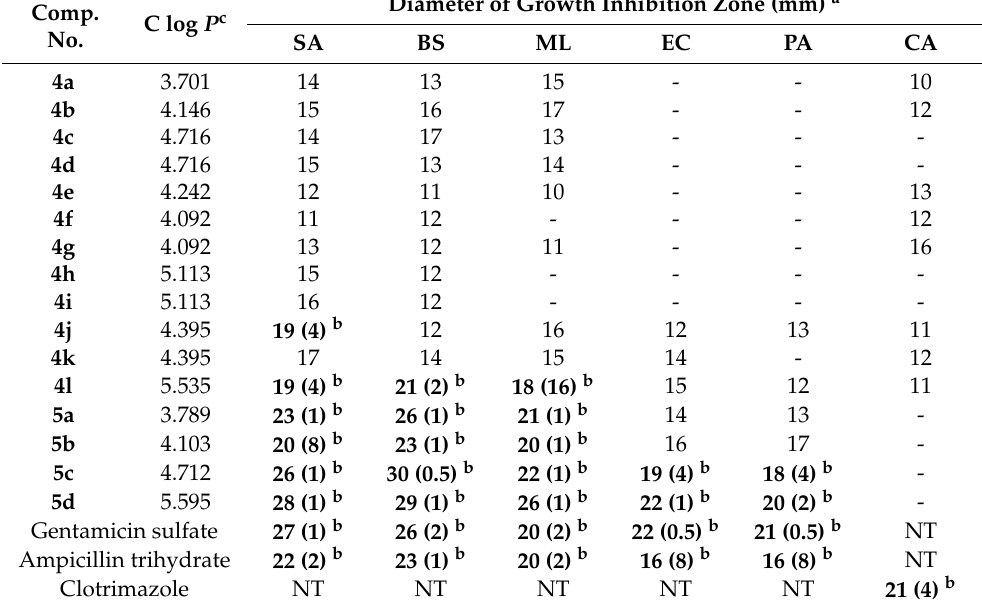
Table 2. In vitro activity of compounds 4a – l and 5a – d (200 µ g/8 mm disc); the broad-spectrum antibacterial drugs Gentamicin sulfate, Ampicillin trihydrate, and the antifungal drug Clotrimazole (100 µ g/8 mm disc) against Staphylococcus aureus American type culture collection (ATCC) 6571 (SA), Bacillus subtilis ATCC 5256 (BS), Micrococcus luteus ATCC 27,141 (ML), Escherichia coli ATCC 8726 (EC), Pseudomonas aeruginosa ATCC 27,853 (PA), and the yeast-like pathogenic fungus Candida albicans MTCC 227 (CA). Diameter of Growth Inhibition Zone (mm) Comp. C log P c No.